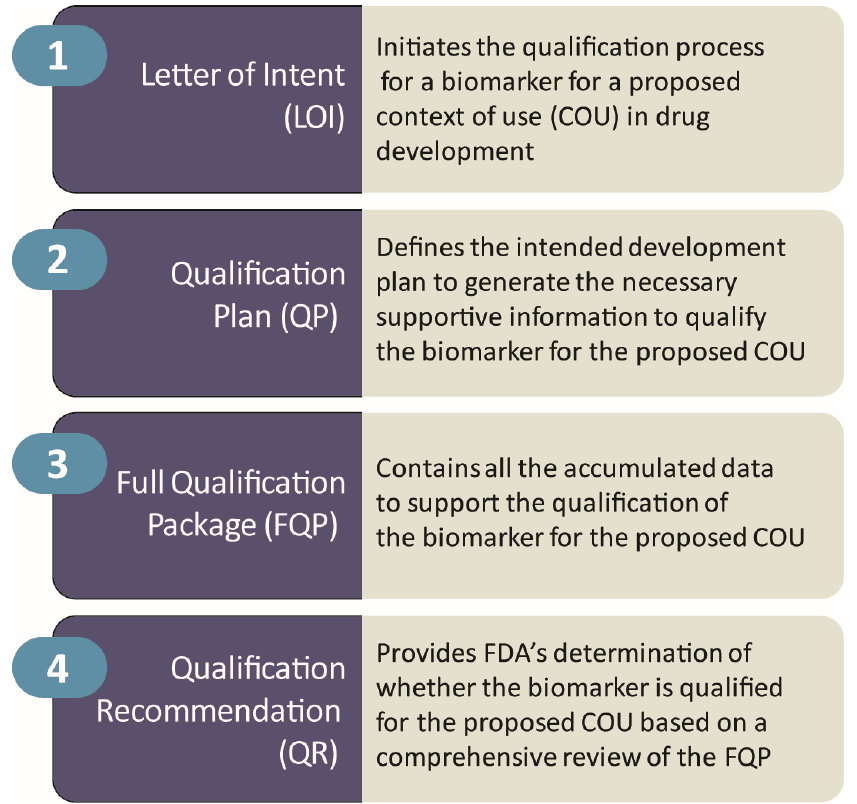
Figure 2. Context of use (COU) process required by the FDA for use of a biomarker as a drug development tool (DDT) in a clinical trial (© J Cummings; M de la Flor, PhD,